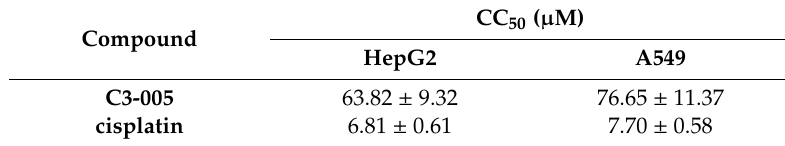
Table 4. Cytotoxicity of C3-005 against Human HepG2 and A549 cell